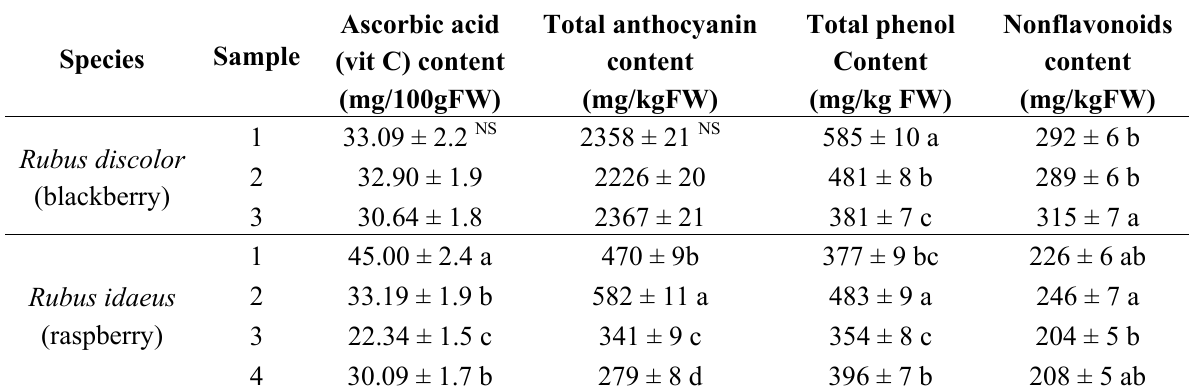
Table 2. The nutritional properties in the fruit of wild berries ( R. discolor and R. idaeus ). Ascorbic acid Total anthocyanin Total phenol Nonflavonoids Species Sample (vit C) content content content Content (mg/100gFW) (mg/kgFW) (mg/kg FW) (mg/kgFW) 1 33.09 ± 2.2 NS 2358 ± 21 NS 585 ± 10 a 292 ± 6 b Rubus discolor 2 32.90 ± 1.9 2226 ± 20 481 ± 8 b 289 ± 6 b (blackberry) 3 30.64 ± 1.8 2367 ± 21 381 ± 7 c 315 ± 7 a 1 45.00 ± 2.4 a 470 ± 9b 377 ± 9 bc 226 ± 6 ab 2 33.19 ± 1.9 b 582 ± 11 a 483 ± 9 a 246 ± 7 a Rubus idaeus (raspberry) 3 22.34 ± 1.5 c 341 ± 9 c 354 ± 8 c 204 ± 5 b 4 30.09 ± 1.7 b 279 ± 8 d 396 ± 7 b 208 ± 5